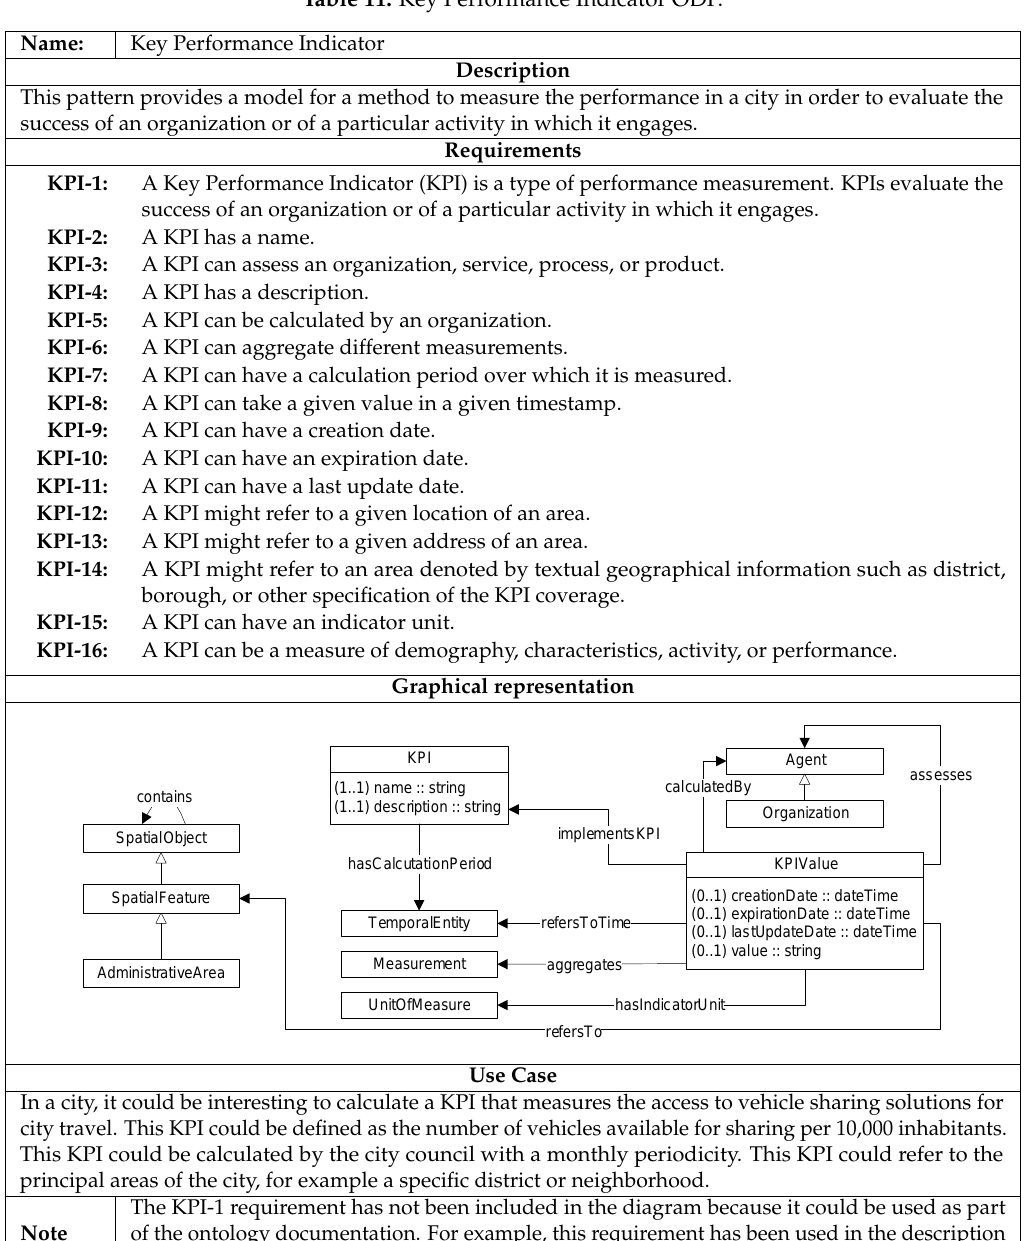
Table 11. Key Performance Indicator